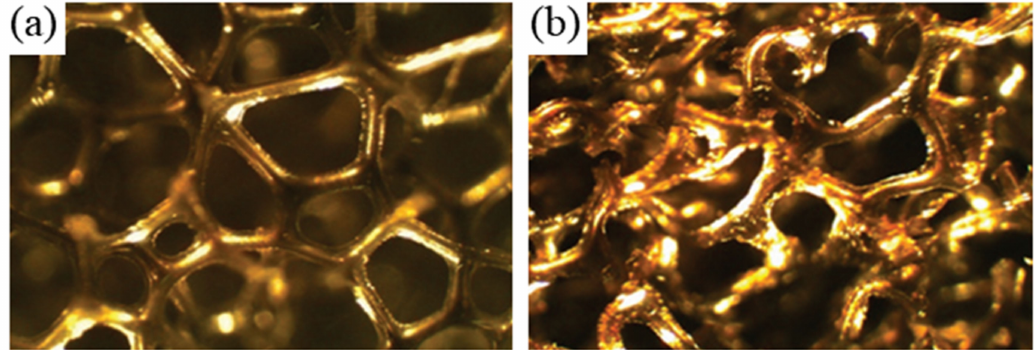
Figure 8. Micrograph of ( a ) conventional cylindrical foam, and ( b ) auxetic cylindrical foam